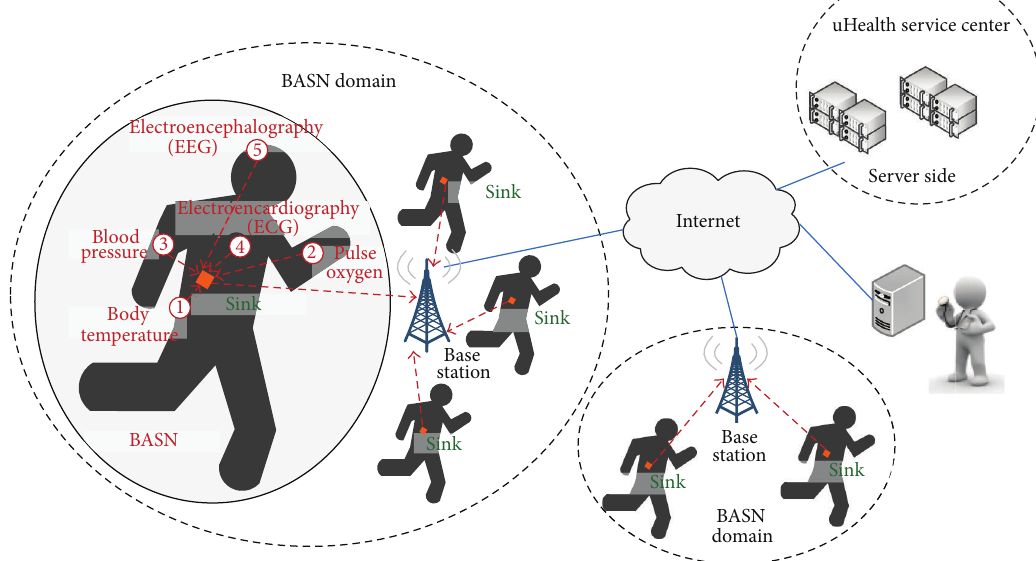
Figure 1: A high-level view of a BASN-based uHealth